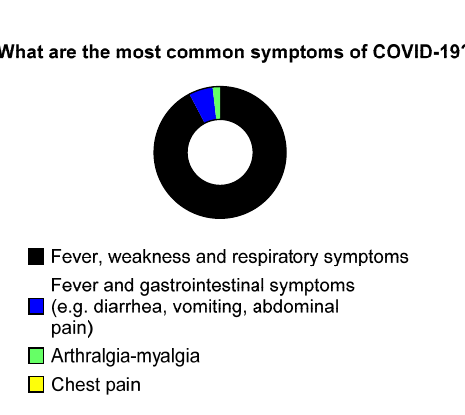
Figure 1. Knowledge of healthcare workers on COVID-19.